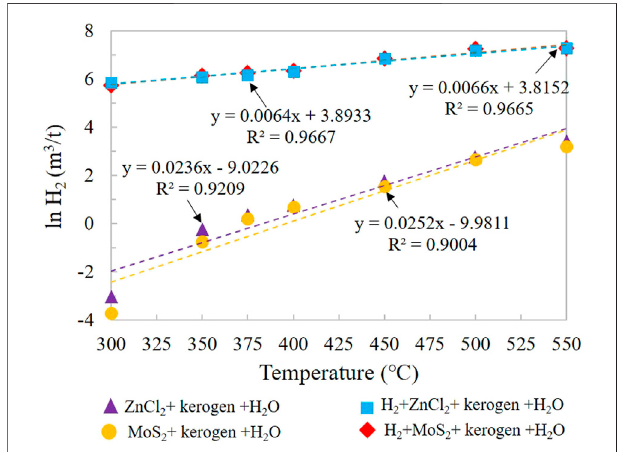
FIGURE 4 | Change in H 2 yield simulated under different catalytic hydrogenation control conditions of the closed